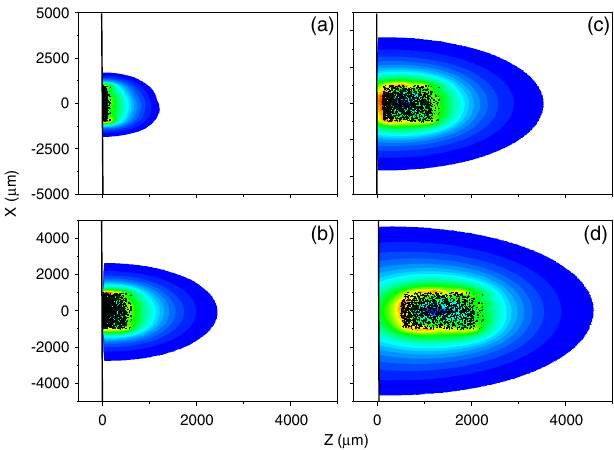
FIG. 12. (Color) j E j in the plane ð z; x Þ for (a) t ¼ 5 psec , (b) t ¼ 10 psec , (c) t ¼ 15 psec , and (d) t ¼ 20 psec . The black scatters are a sample of the 20 000 macroparticles used in the simulation. Total charge is 1 nC